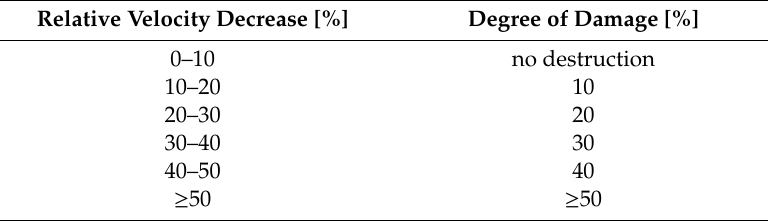
Table 3. Relation between relative velocity decrease and degree of